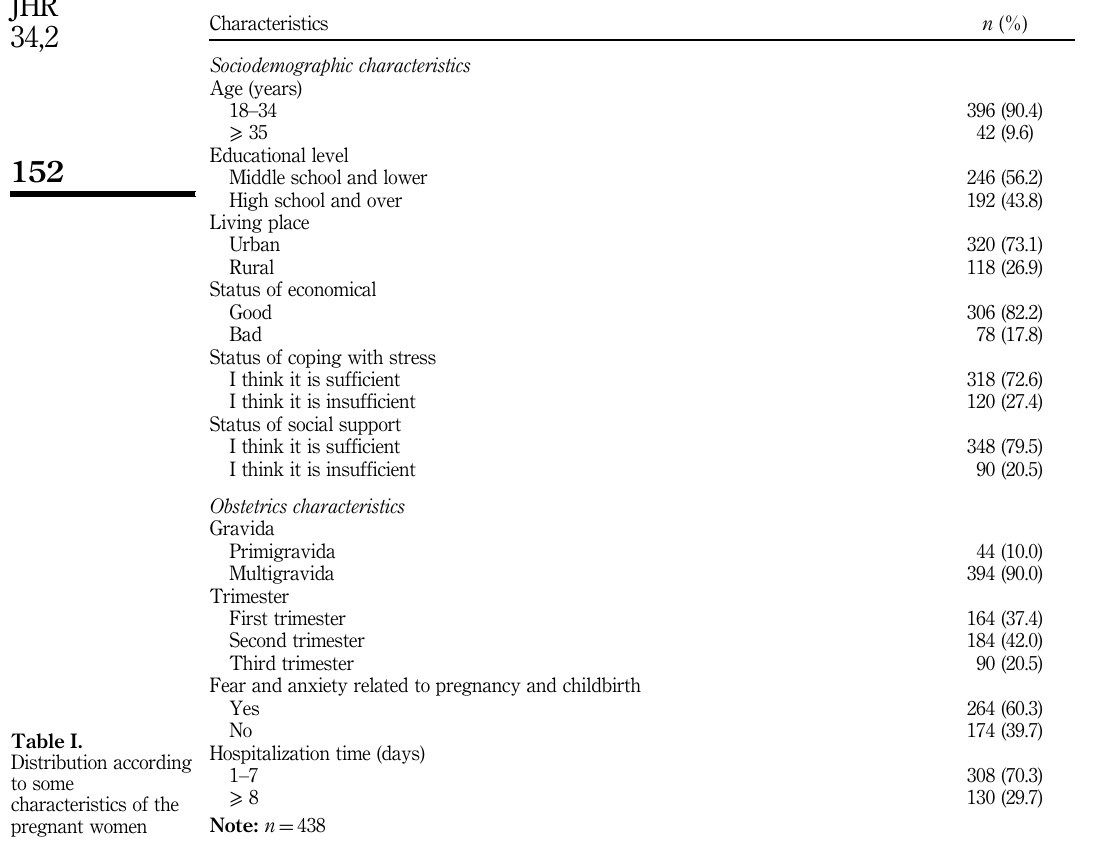
to some characteristics of the pregnant